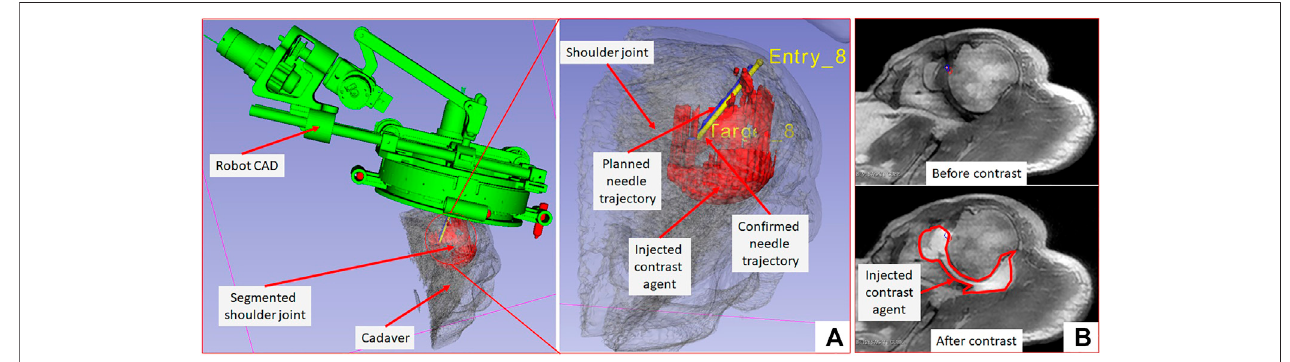
FIGURE 7 | 3D Slicer scene showing segmented 3D volume of the glenohumeral joint, injected contrast agent, target and entry locations, and planned and achieved needle